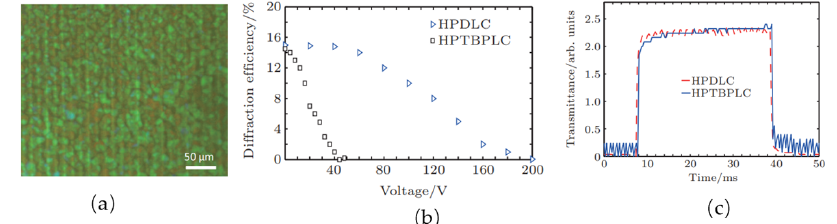
Figure 9. ( a ) Platelet textures observed with the POM for the HPTBPLC grating; ( b ) experimental results for the first-order diffraction efficiencies of HPDLC grating (triangles) and the HPTBPLC grating (squares), respectively; ( c ) measured response times of the HPDLC (dashed curve) and the HPTBPLC (solid curve) gratings. Reprinted with permission from Ref. [88]. Copyright 2015 Chinese Physics